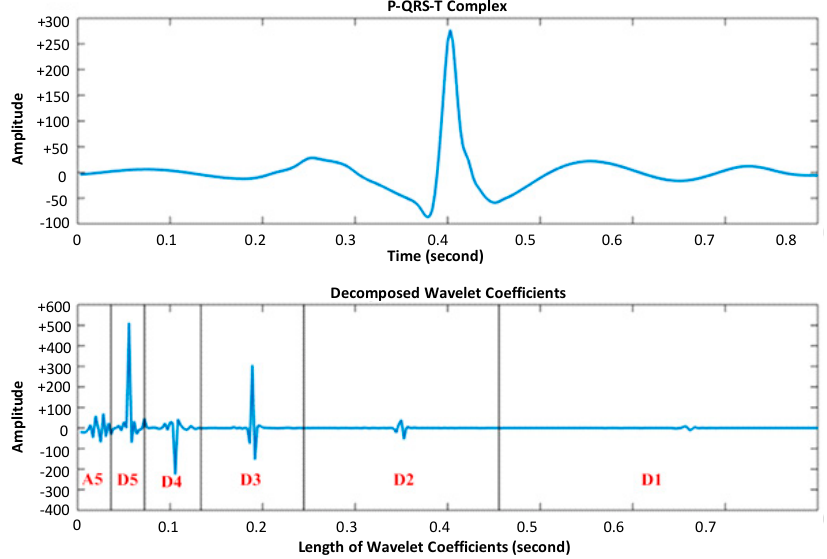
Figure 7. The 5-level decomposition using Daubechies discrete wavelet transform (DWT).